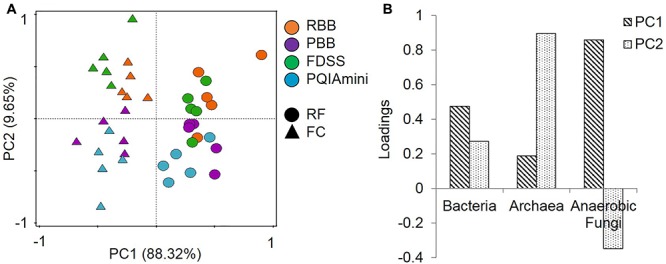
(A) Principal component analysis (PCA) of the combined bacterial (16S rRNA gene), archaeal (16S rRNA gene) and anaerobic fungal (5.8S rRNA gene) qPCR data for rumen fluid (RF, Δ) and fibrous content (FC, aaa) samples. The GS100 diet has duplicate DNA extracts presented as individual datapoints. The percentages provided at the axes indicate the variation explained. (B) The corresponding loadings for the principal components indicate that anaerobic fungi are the major cause of sample separation in PC1, and archaea in PC2.